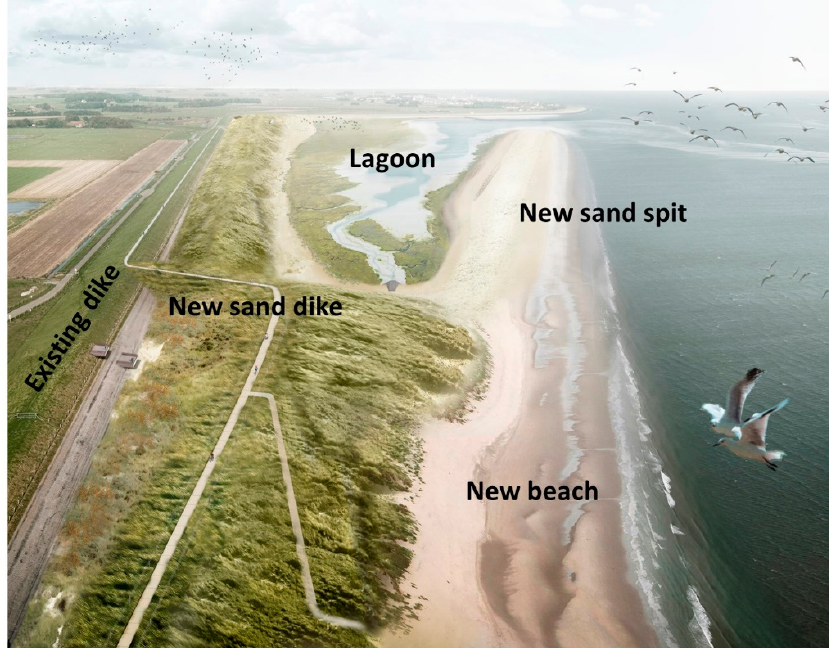
Figure 1. Artist impression new Prins Hendrik sand dike (Source: Feddes and Olthof).